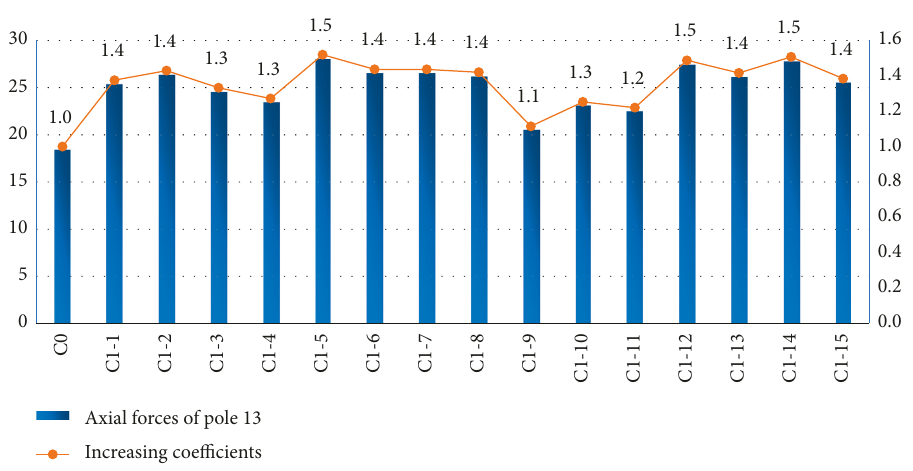
Figure 14: Axial forces and increasing coefficients of pole 13 in interval